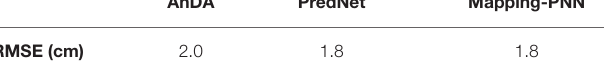
TABLE 2 | The RMSE of the AnDA method, the PredNet method, and the Mapping-PNN method. AnDA